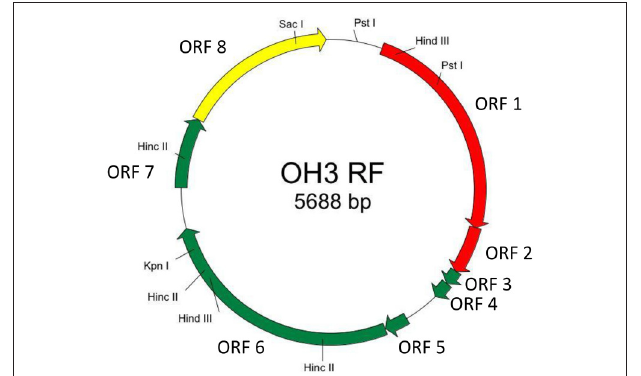
FIGURE 4 | Genetic map of ϕ OH3 RF DNA. Predicted ORFs are indicated by arrows. Arrow colors show putative gene functions as follows: replication, red; structure, green; assembly, yellow. Since the conserved domain of Zot was detected in the ORF8 product, ORF8 might function for phage assembly.